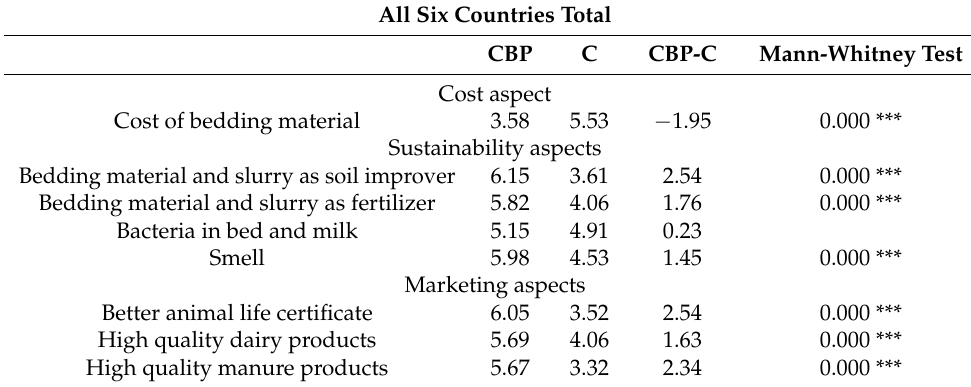
Table 1. Appreciation of composting bedding material in CBP versus regular manure in cubicle housings (C) by farmers from these two farm housing systems in six European countries (scores from 1 = very negative to 7 = very positive) 1,2 .